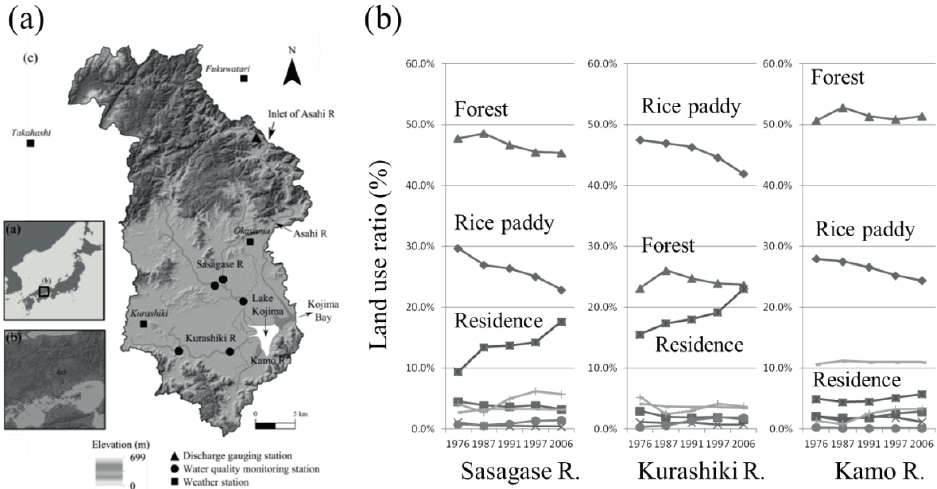
Fig. 1 Study area: (a) location of monitoring station, and (b) land-use